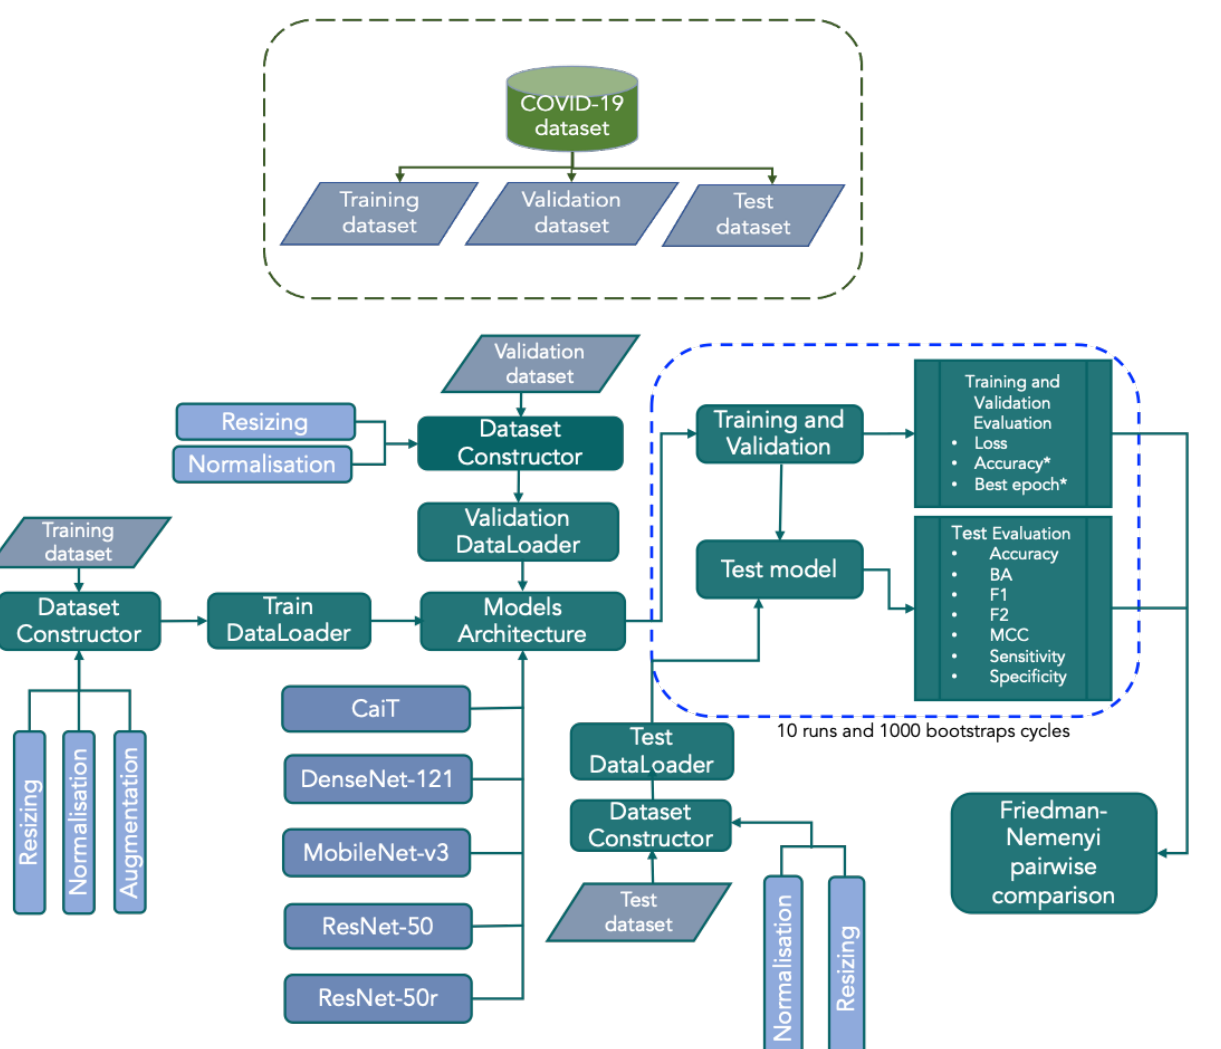
Figure 2. Graphical illustration of the pipeline steps used for the training, evaluation and comparison of the deep neural network models for the classification of COVID-19 in a multi-class setup used in this work. All outputs from test phased were bootstrapped. Training, validation and test were run 10 times. After this, the test and validation results were further bootstrapped for 1000 cycles. * Indicates the bootstrapped outputs from validation